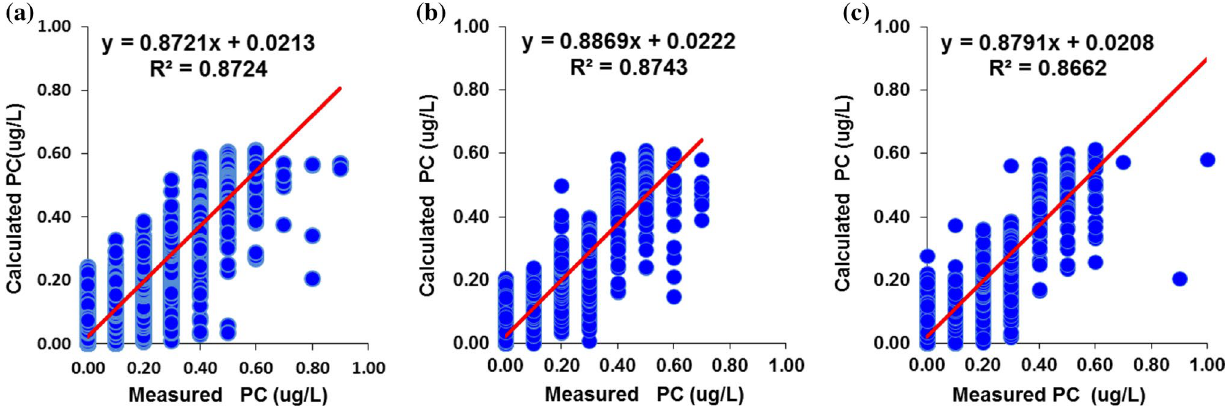
Fig. 7 Scatterplots of estimated versus measured values of PC for FFNN (M1) model: a training, b validation and c test data—Station ID: